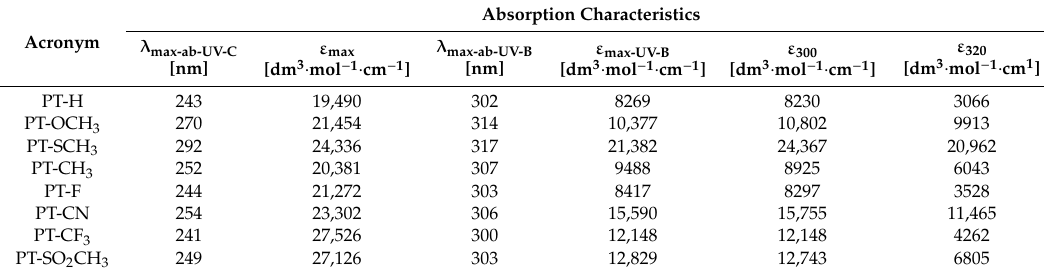
Figure 2. UV-visible absorption spectra of the 2,6-diphenylpyridine derivatives in acetonitrile. Table 1. Spectral characteristics of the 2,6-diphenylpyridine derivatives.